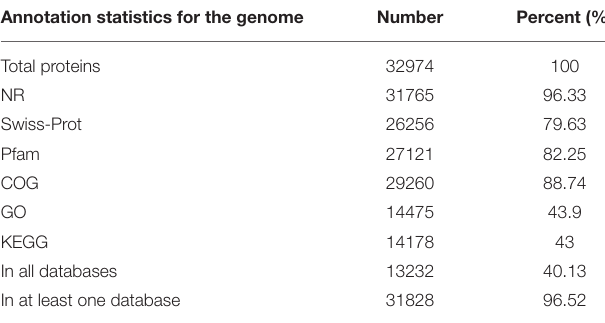
TABLE 2 | Annotation statistics for the S. cusia